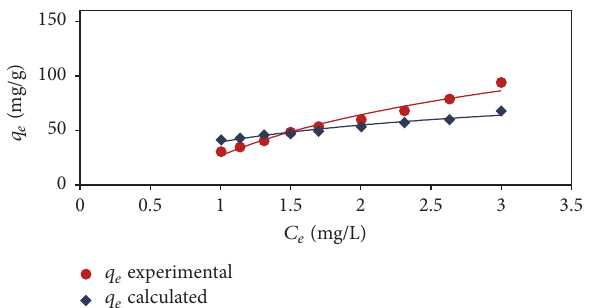
Figure 16: Jain and Snoeyink model for RR-RB in binary system with RB-5 (temp. = 25 ∘ C, speed = 200 rpm, time = 24 hr., and con. of RR-RB = con. of RB-5 =